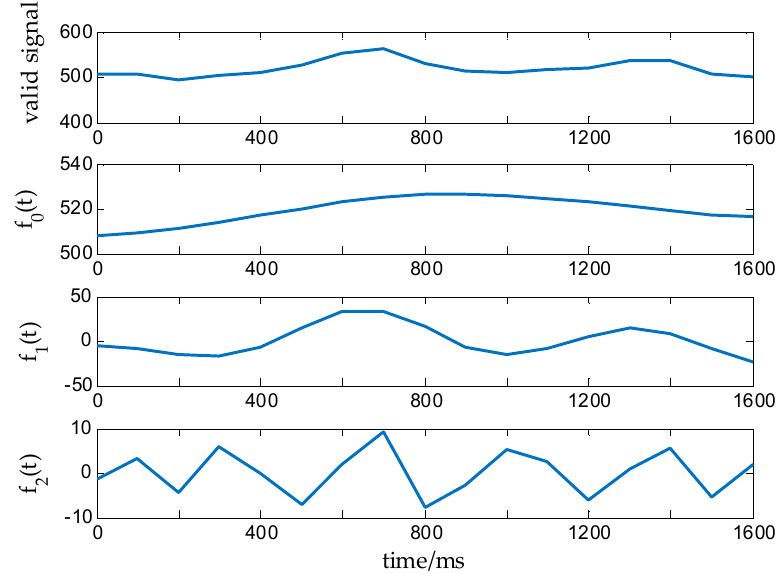
Figure 6. EWT decomposition diagram for a medium-grade activity signal.